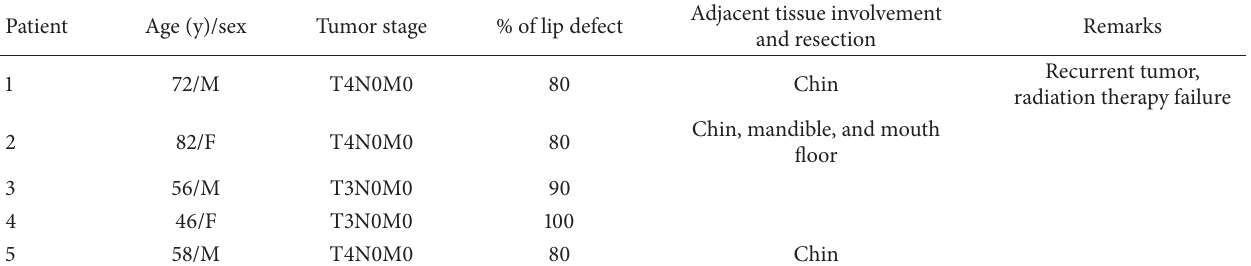
Table 1: Patient and tumor characteristics.